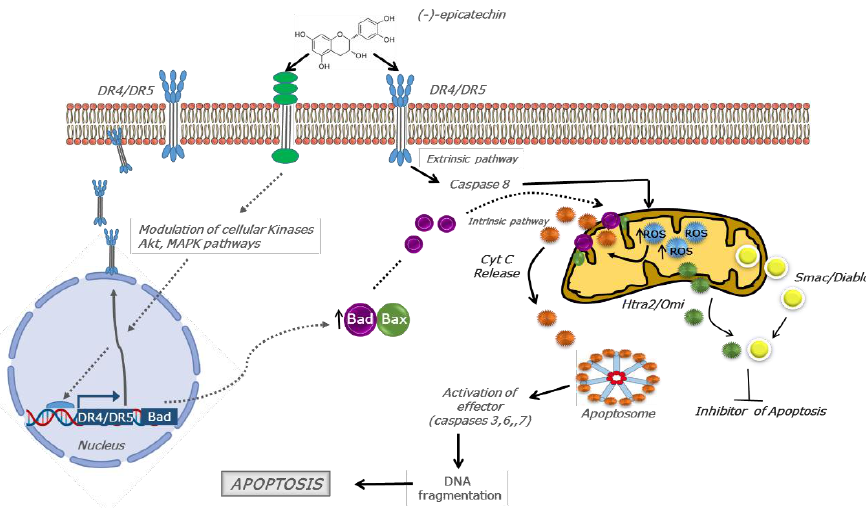
Figure 6. Schematic representation of (−)-epicatechin anticancer activity in MDA-MB-231 and MCF-7 cells. The anticancer effect in MDA-MB-231 cells was possibly triggered through TRAIL receptor interaction (DR4/DR5) and its upregulation. This extrinsic pathway activation was enhanced through the intrinsic pathway, resulting in caspases-dependent apoptosis and enhanced by the modulating of inhibitors of apoptosis by Smac/Diablo and HtrA2/Omi (continuous arrow). In MCF-7 cells, an anticancer effect was evident through the interaction with another receptor, the modulation of cellular kinases, and the upregulation of pro-apoptotic proteins such as Bad and Bax. This Bad and Bax upregulation induced the leak of cytochrome C, Smac/Diablo, and HtrA2/Omi into the cytoplasm, activating apoptosis through the intrinsic pathway. These mechanisms are tightly related to ROS generation (dashes arrow). (Arrows indicate activation, ⊥ indicates inhibition).